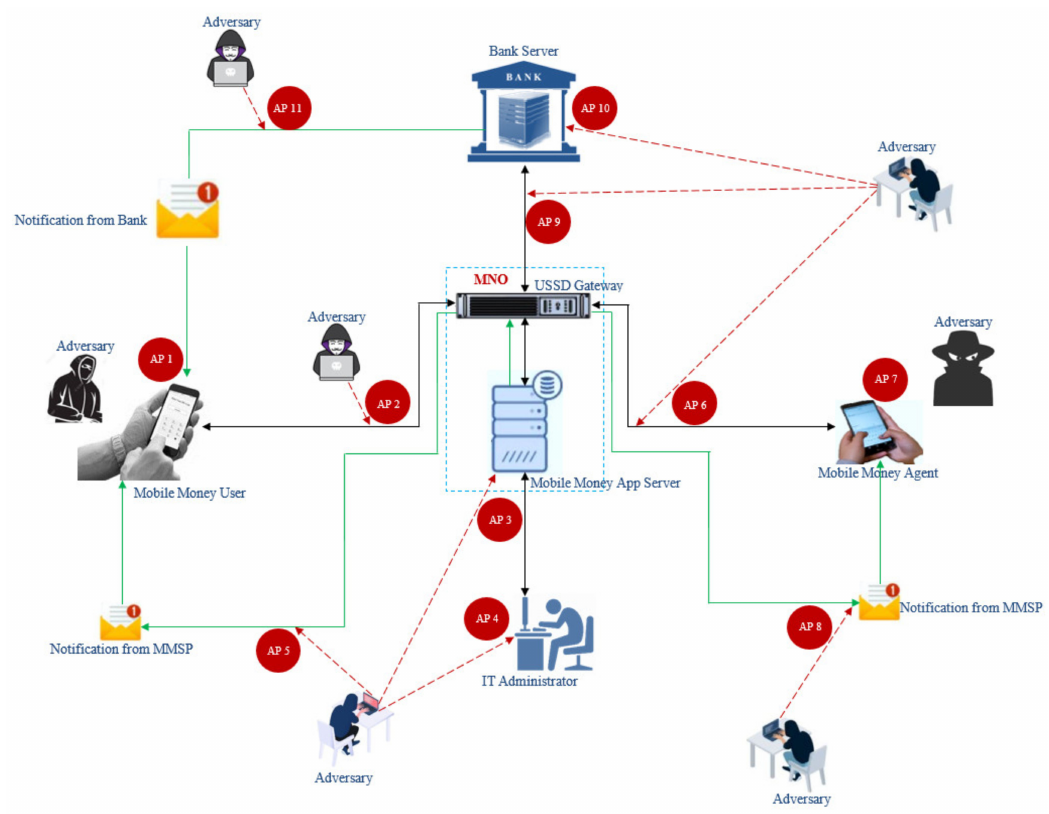
Figure 4. The red dashed line with an arrow represents an attack point (AP) on di ff erent components of the